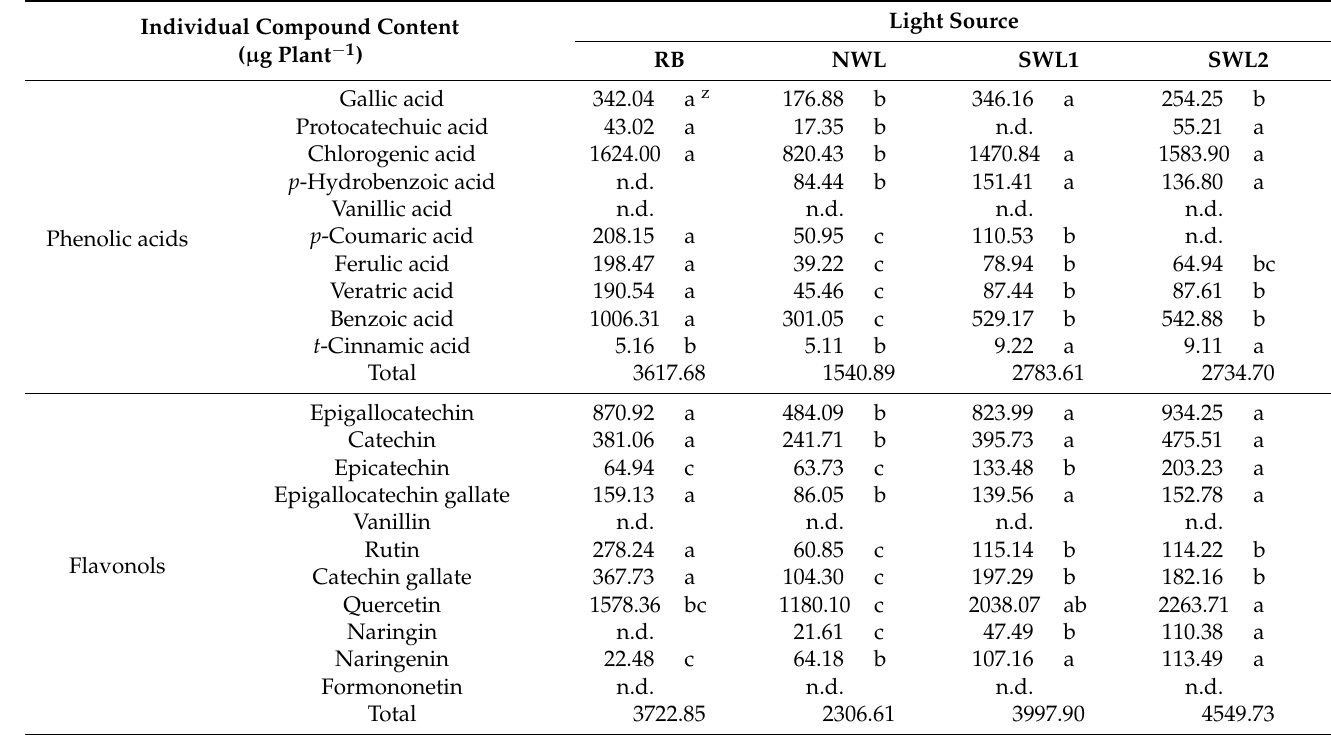
Table 6. Individual phenolic acid and flavonol contents of romaine lettuce grown under various light sources with the same PPFD after 4 weeks of transplanting. Different letters indicate significant difference at p < 0.05 ( n = 4). Individual Compound Content